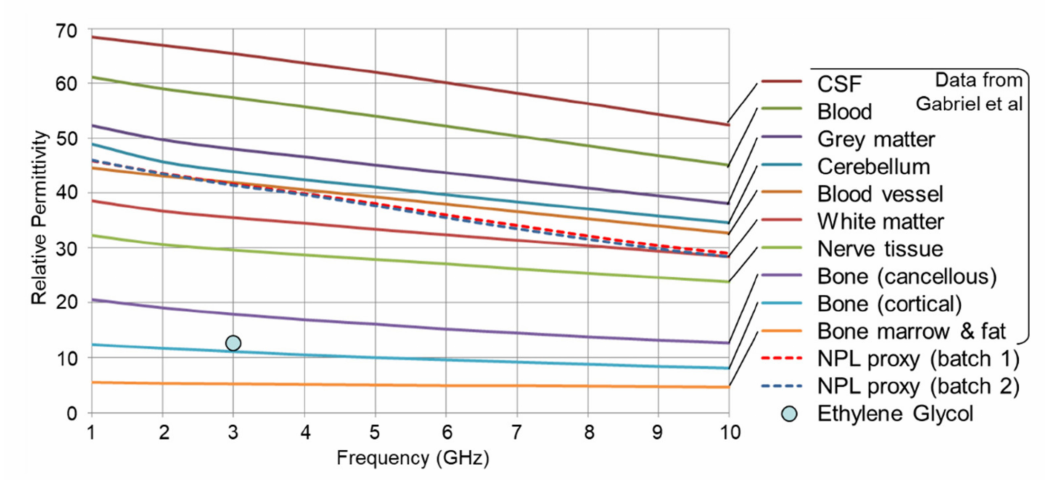
Figure 4. Relative permittivities of the proxy fluids obtained from NPL and published plots for other human anatomical